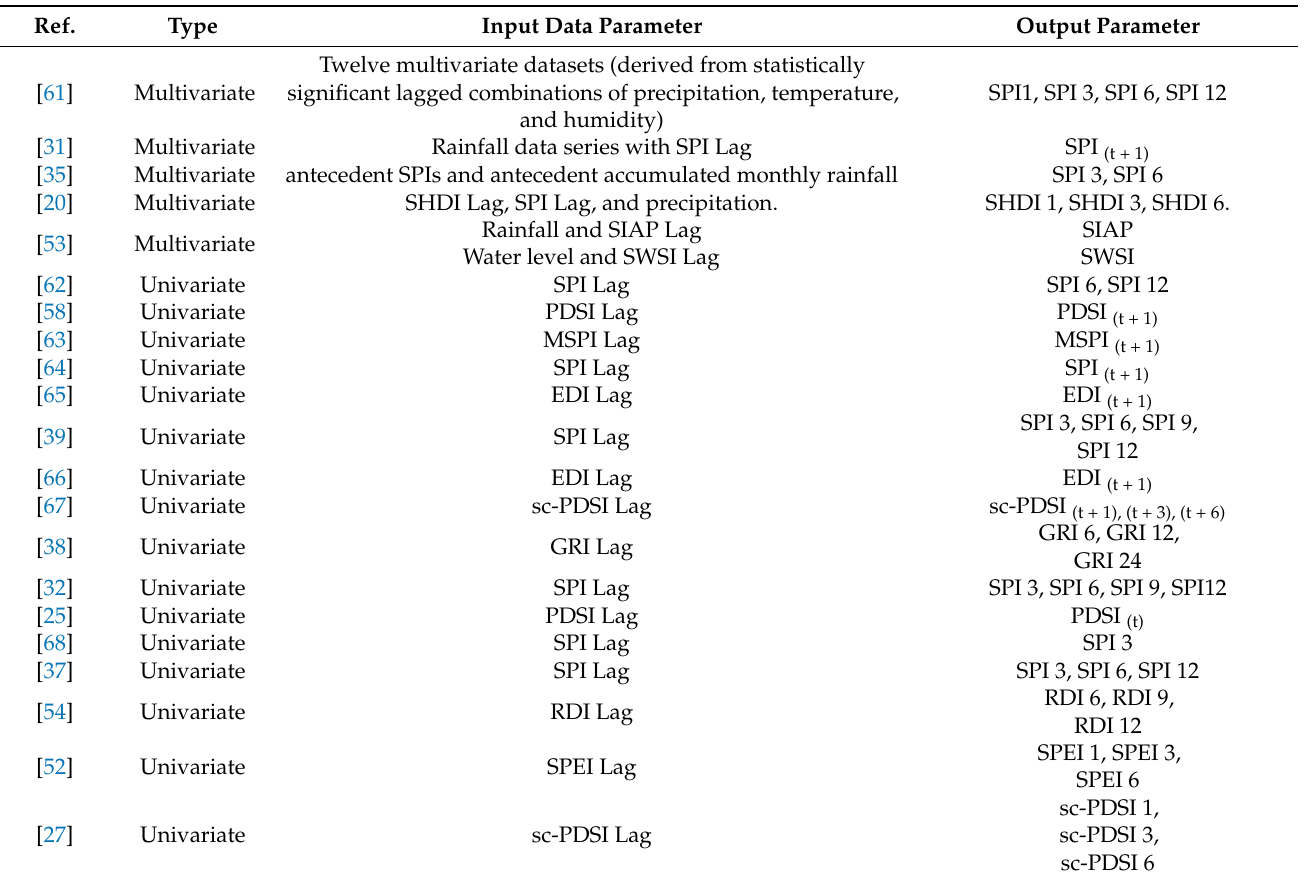
Table 5. Different input